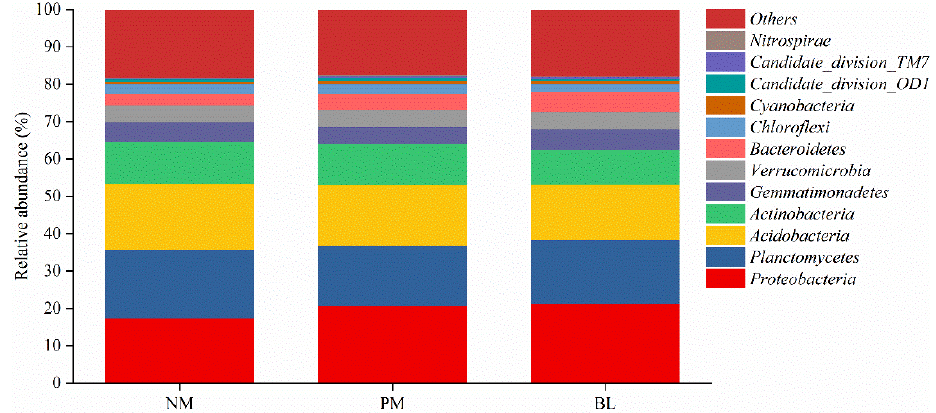
Figure 2. Percent distribution of soil bacterial phyla in the three treatments. NM: non-mulched spring maize (control); PM: plastic-mulched spring maize; BL: bareland fallow. n = 3 (NM, PM, BL). As a major phylum of Gram-negative bacteria, Proteobacteria are free-living (non-par-